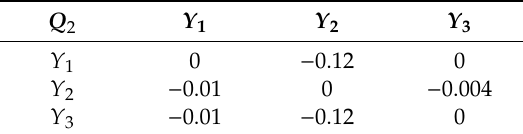
Table 5. The regret matrix Q 2